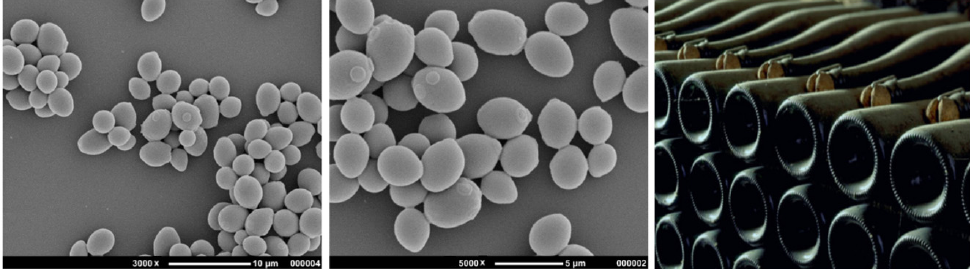
Figure 2. S. cerevisiae cells visualised using scanning electron microscopic (images on the left, reproduced from [16]). Sparkling wine bottles during the prise de mousse (image on the right, reproduced from [17]).